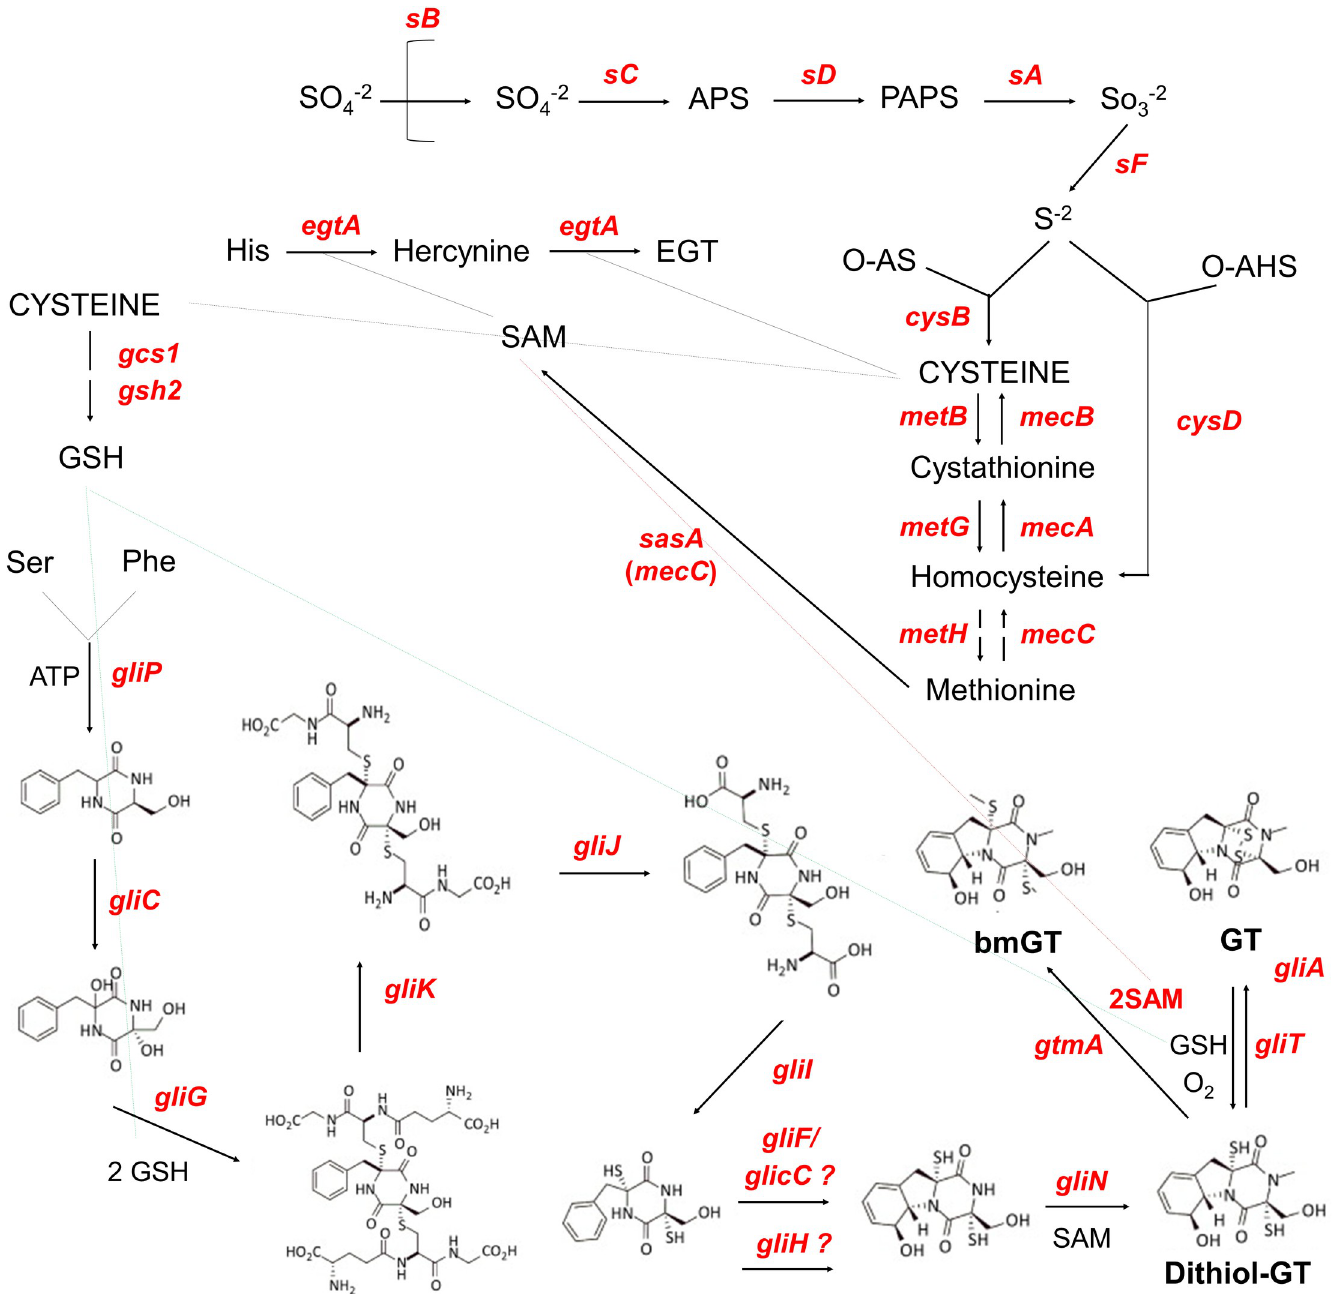
Fig 10. Schematic representation of the pathways that are important for GT production and self-defense. – The pathways of sulfate assimilation, transsulfuration, and GT production are shown in the scheme. The depicted genes are: sB , sulfate transporter; sC , ATP sulfurylase; sD , adenosine 5’- phosphosulfate (APS) kinase; sA , 3’-phosphoadenosine-5’-phosphosulfate (PAPS) reductase; sF , β -subunit of the sulfite reductase; AFUA_6G08920, α -subunit of the sulfite reductase; cysB , cysteine synthase; metB , cystathione- U -synthase; metG , cysthationine- β -lyase; metH , methionine synthase; mecC , 5-adenosylmethionine synthetase; mecA , cystathionine- β -synthase; mecB , cystathionine- U -lyase; cysD , homocysteine synthase; gliP , n on-ribosomal peptide synthetase; gliC , cytochrome P450 monooxygenase; gliG , glutathione-S-transferase; gliK , unknown protein; gliJ , membrane dipeptidase; gliI , 1-aminocyclopropane- 1-carboxylic acid synthase; gliF , cytochrome P450 monooxygenase; gliC , cytochrome P450 monooxygenase; gliH , acetyl transferase; gliN , methyltransferase; gliT , gliotoxin sulfhydryl oxidase; gliA , major facilitator type glioxin transporter; gcs1 , glutamate cysteine-ligase; gsh2 , glutathione synthase; egtA , ergothioneine synthase ; and gtmA , bis -thiomethyltransferase. Abbreviations: O-AS, O -acetylserine; O-HS, O- acetylhomoserine; GSH, glutathione; SAM, S-adenosyl methionine; EGT, ergothioneine; bmGT, bisdethiobis(methylthio)-gliotoxin ; and GT, gliotoxin .